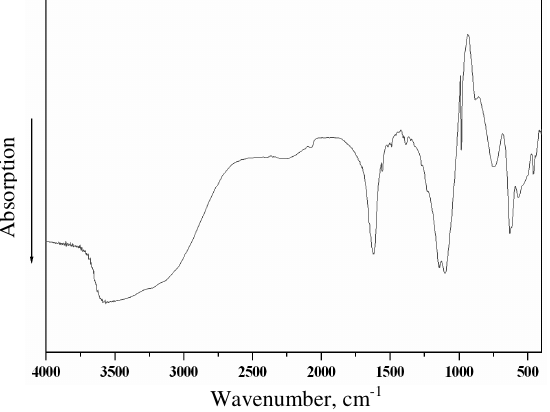
Figure 4. IR absorption spectrum of [C